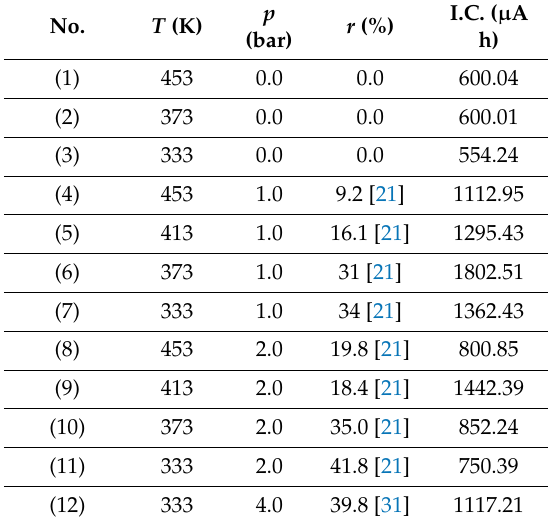
Table 1. Thermodynamic conditions of the samples measured on MARI and experimental results, including sample number, temperature T , pressure p , hydrogen uploading (expressed as ratio, r, between hydrogen atoms and metal atoms), integrated proton current I.C. (the average ISIS proton current being about 180 µ A). Refs. [21,31] provide the relationship between thermodynamic conditions and H